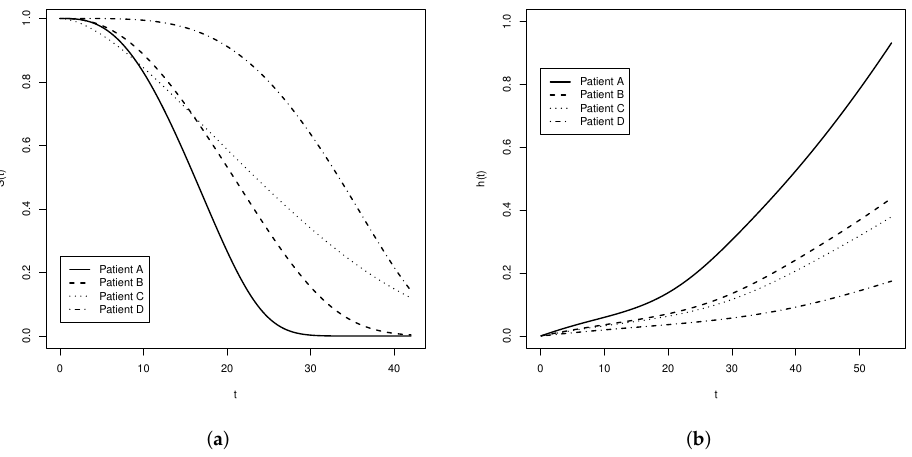
Figure 10. ( a ) Estimated survival functions. ( b ) Estimated hazard